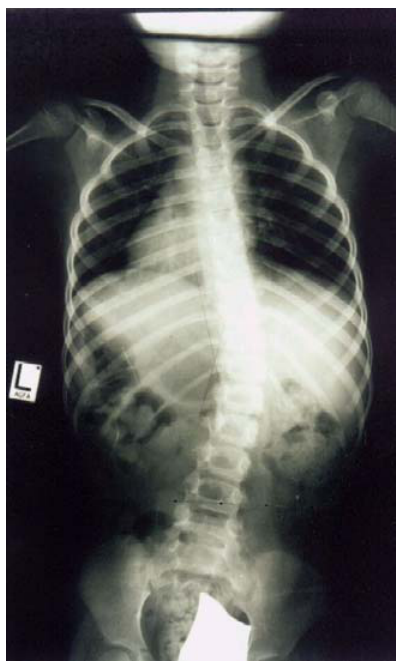
FIGURE 3 . X-ray taken on February 16, 2000, in supine position showing 20º